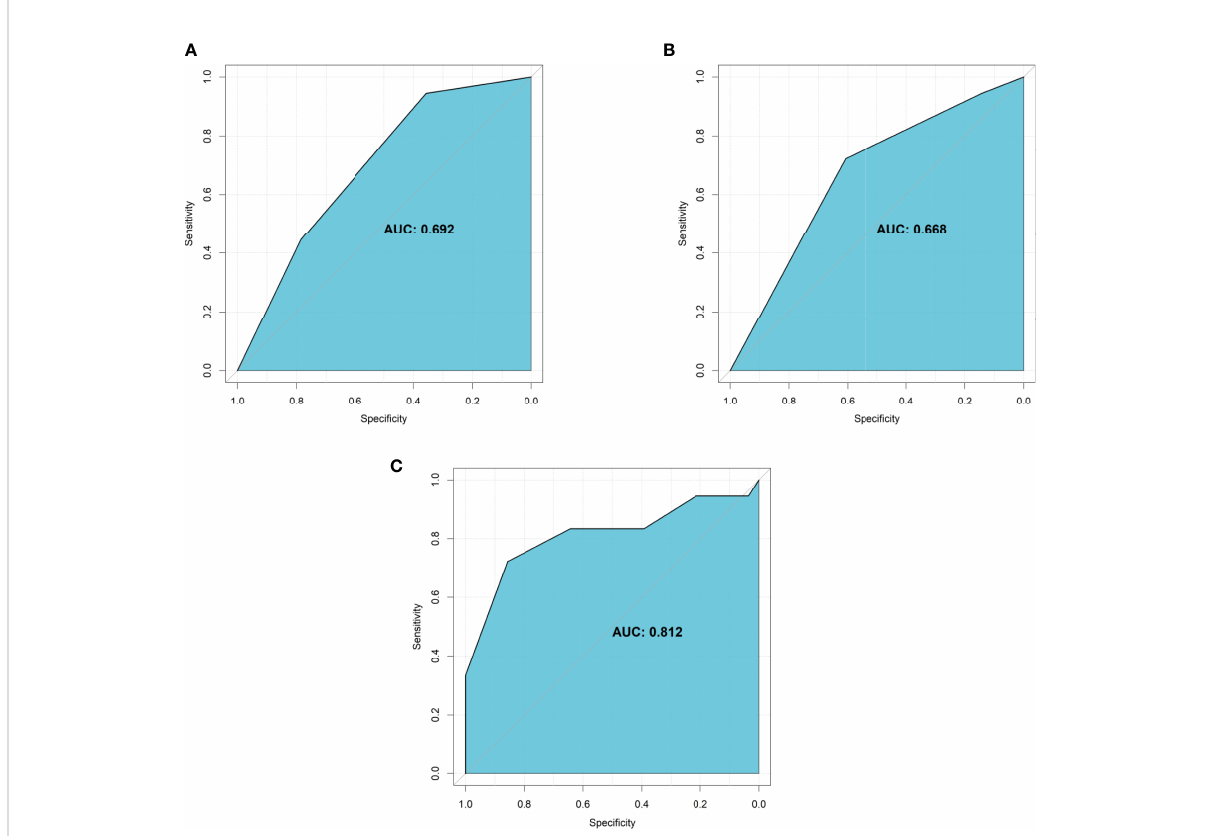
FIGURE 5 The AUROC of signi fi cant characteristics for predicting intra-operative blood loss. (A) Tumor vascularity alone; (B) Extent of embolization alone; (C) The combination of tumor vascularity and extent of